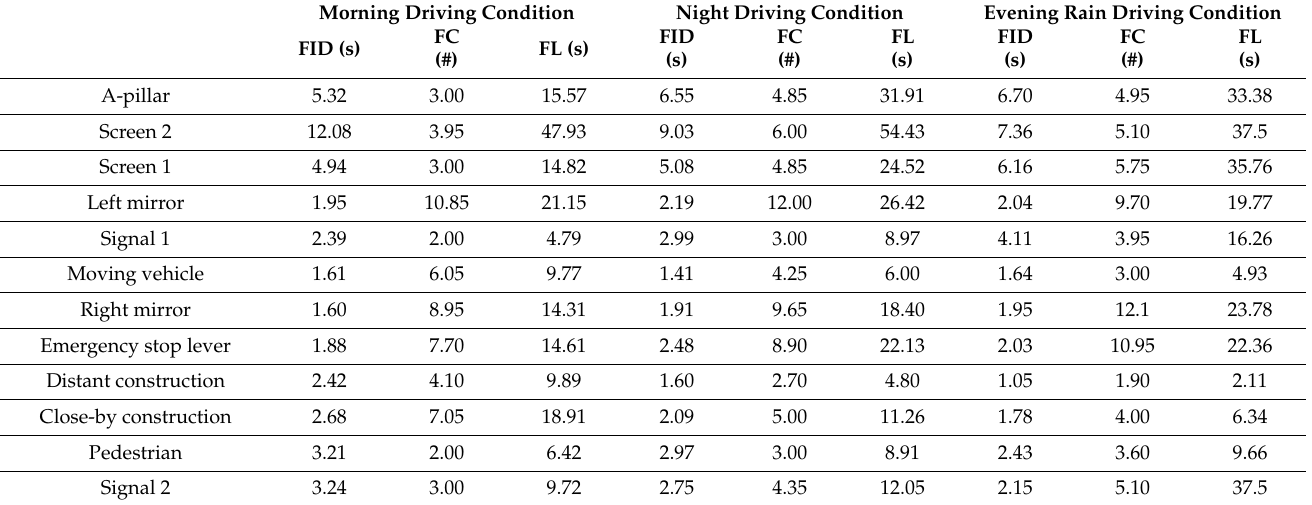
Table 2. Average values of driver responses for all hazards across all driving